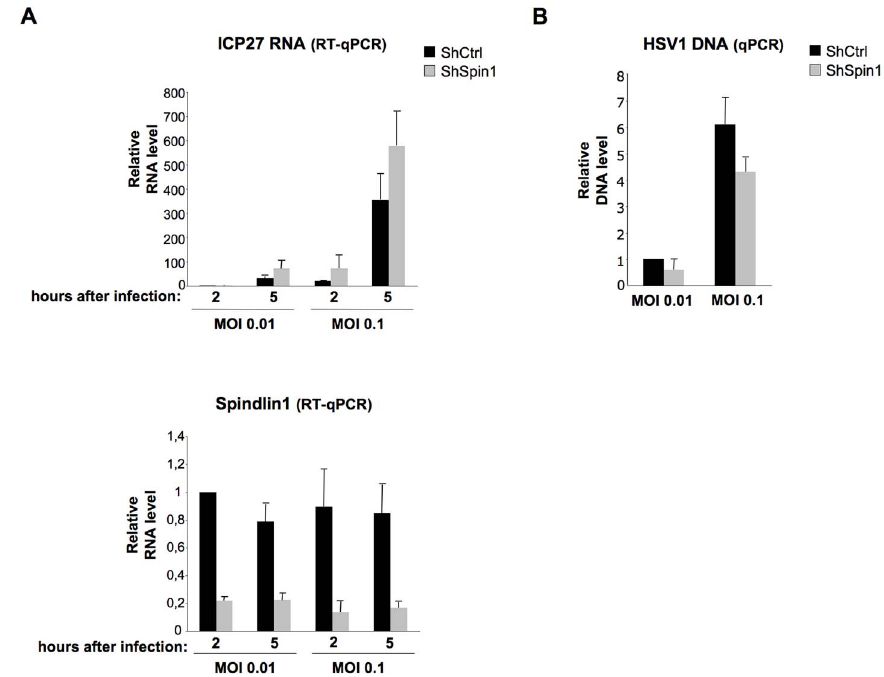
Figure 5. Spindlin1 represses the transcription of HSV-1 during infection. ShCtrl or shSpin1 HepaRG cells were infected in duplicate with HSV1 at MOI 0.01 and 0.1. Cells were harvested at 2 h and 5 h post-infection for total RNA extraction and viral DNA extraction. ( A ) HSV-1 ICP27 immediate early RNA transcription was quantified by RT-qPCR (upper panel). Spindlin1 expression in shCtrl or shSpin1 HepaRG cells was analyzed by RT-qPCR (bottom panel). Transcript level in shCtrl HepaRG cells 2 h after HSV-1 infection was set to 1. Error bars represent SD of two independent experiments. ( B )The amount of HSV-1 DNA in shCtrl HepaRG cells 2 h after infection was analyzed by qPCR. HSV-1 DNA level in shCtrl HepaRG cells 2 h after HSV-1 after infection was set to 1. Error bars represent SD of two independent